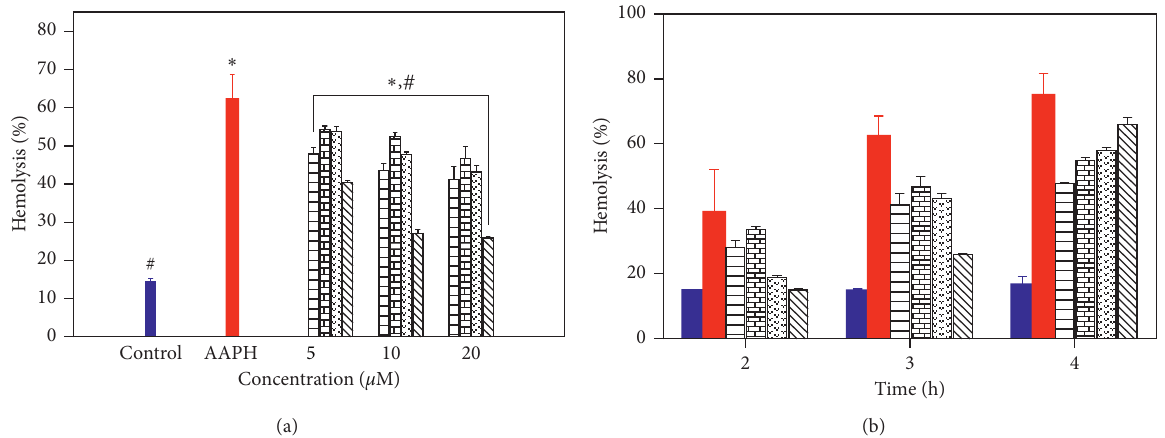
Figure 7: (a) Protective effect of piperine derivatives on AAPH-induced hemolysis of erythrocytes (3h). (b) Kinetic curve of the protective effect of piperine derivatives on AAPH-induced hemolysis of erythrocytes at 20 μ M. Control ( ); AAPH ( ); AAPH+ 5a ( ); AAPH+ 5b ( ); AAPH + 5c ( ); AAPH+ 5d ( ). ∗ indicates a significant difference from the control group ( p < 0 . 05); indicates a significant difference from the AAPH